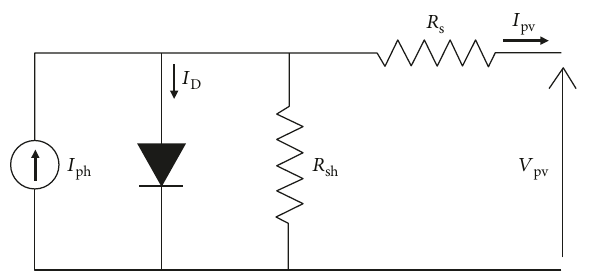
Figure 2: The single-diode model of a PV